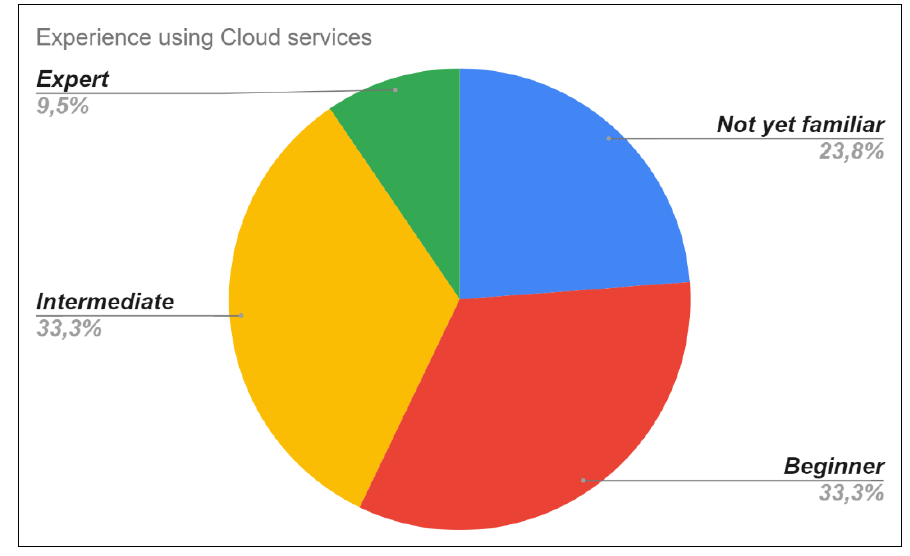
Figure 10. User experience using Cloud